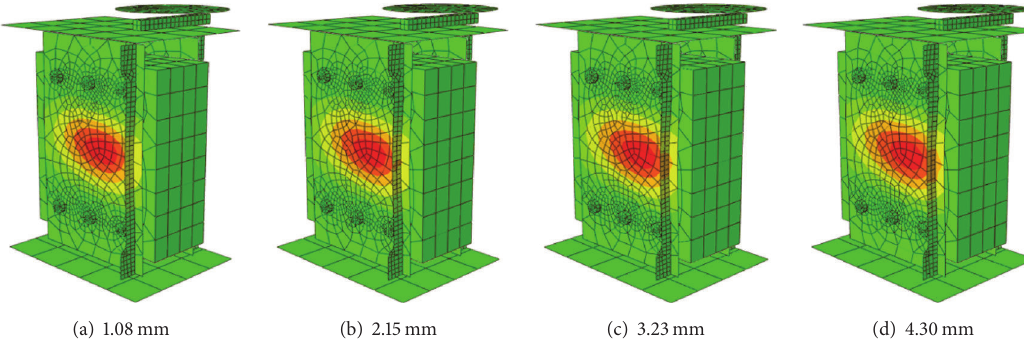
Figure 11: Failure modes of models with different initial